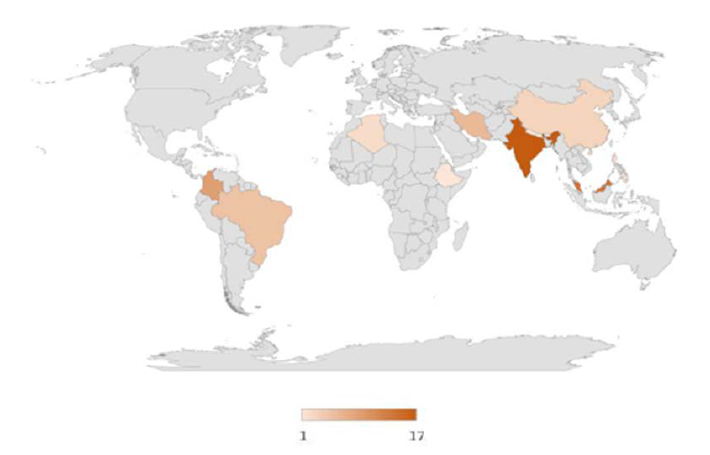
Figure 9. Studies on MSD in agriculture (1995–2020). Developing